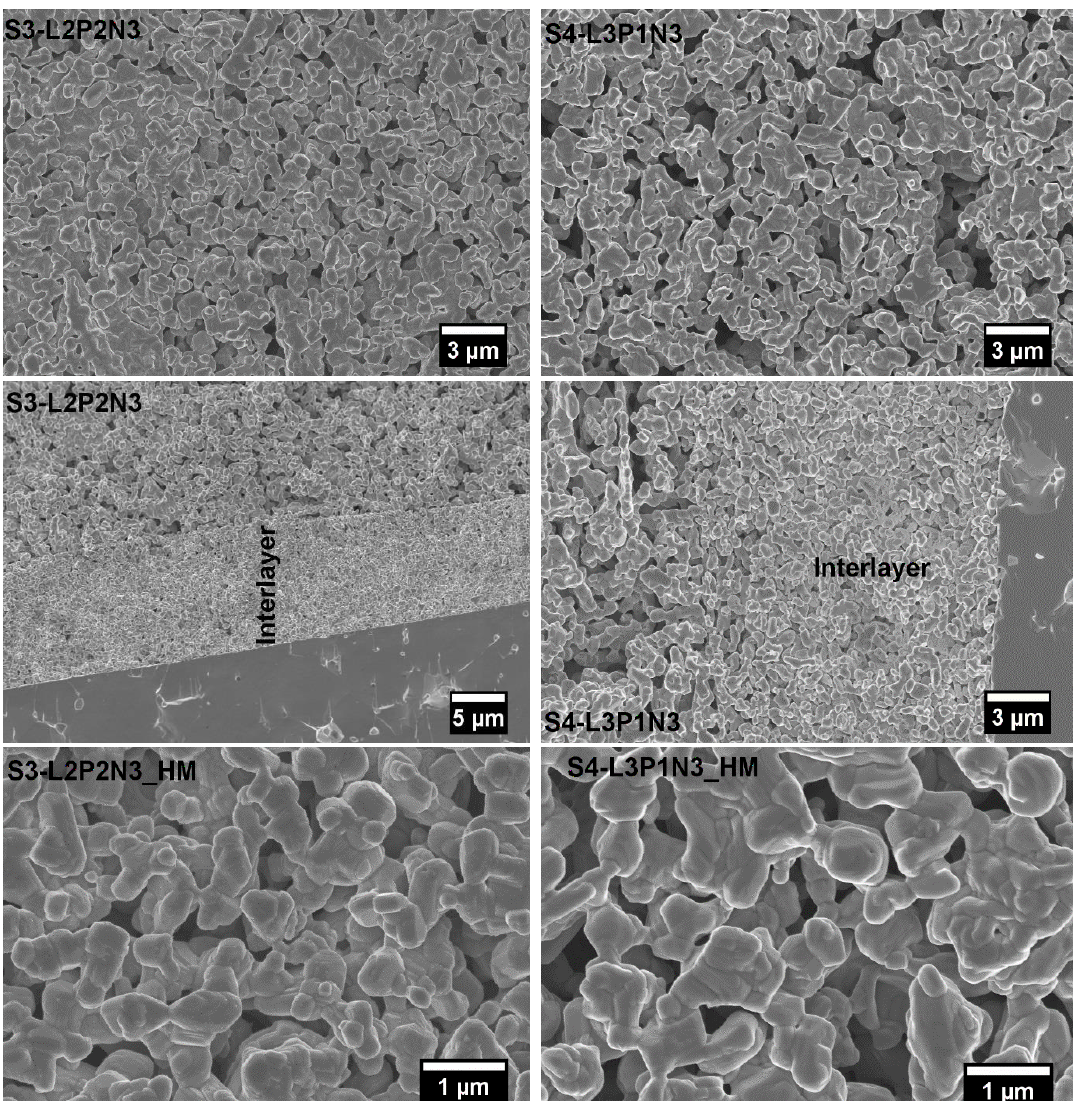
Figure 5. Post-test microstructural secondary electron SEM images showing the TV and CS view of the electrode in sample 3 (L2P2N3) and sample 4 (L3P1N3). The cross-section view shows strong adherence of the electrode layer, as was observed in samples 1 and 2. Top-view SEM images show virtually no particle coarsening in samples 3 and 4. The high-magnification (HM) images further illustrate the improved particle interconnectivity and porous cathode structure.